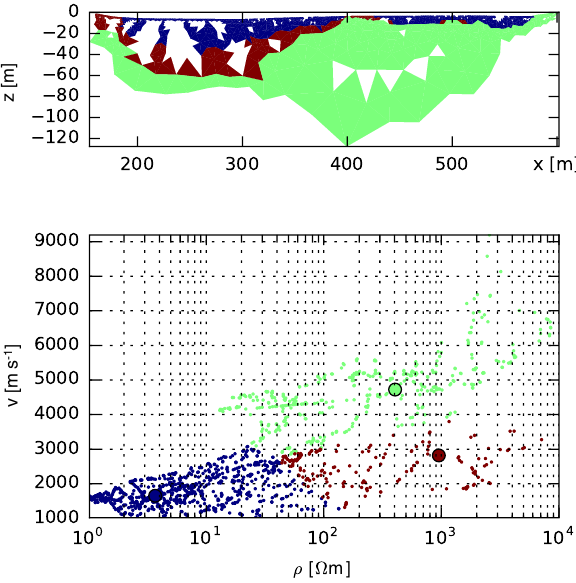
clusters. The upper picture shows the spatial distribution of the clus- ters and the lower one shows the parameter distribution within each cluster.